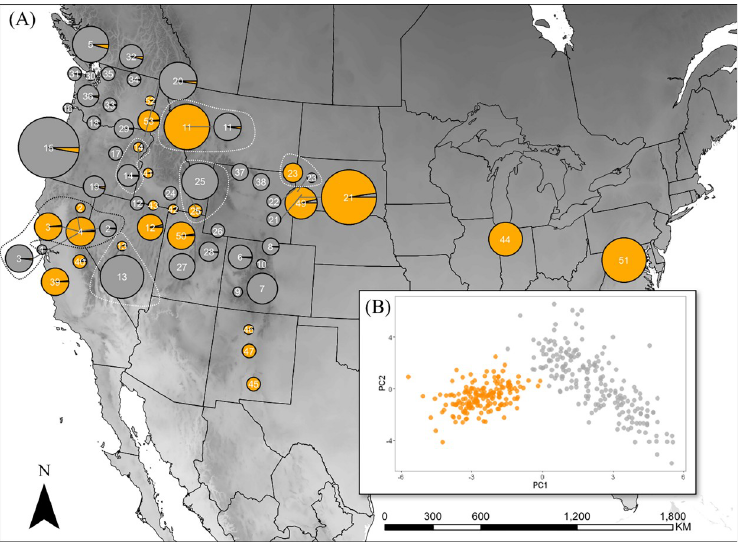
Fig 3. Map and principal components analysis of B . fervidus species complex microsatellite genotypes. (A) Spatial distribution of K = 2 genetic clusters, genetic cluster 1 (gray circles) and genetic cluster 2 (orange circles) inferred from a Bayesian analysis of 13 microsatellite loci implemented in Structure. The size of each circle represents the number of specimens genotyped per locality. Fractional genotypes are averaged across specimens within each genetic cluster (see Fig 2B for individual genotype assignment to a lineage). Populations enclosed by a black or white dotted polygon represent localities where genetic cluster 2 and genetic cluster 1 are geographically sympatric ( i . e ., Site 2: 0.92 km SSW of Sierra Valley, Sierra County, California; Site 3: 1.52 km SSW Sierraville, Sierra County, California; Site 4: 2.33 km WNW Sierraville, Sierra County, California; Site 14: 32.5 km NE Baker City, Baker County, Oregon; Site; Site 11: MPG Ranch, Bitterroot Valley, Missoula County, Montana; Site 13: Toiyabe Range, Birch Creek, site 5, Lande County, Nevada); Site 25: Logan Canyon, Cache County, Utah; Site 23: Mirror Lakes, Pennington County, South Dakota). The number at the center of each pie chart represents the field sites described in Table 1. (B) Principal component analysis of 13 microsatellite loci shared between genetic cluster 1 (gray points) and 2 (orange points).